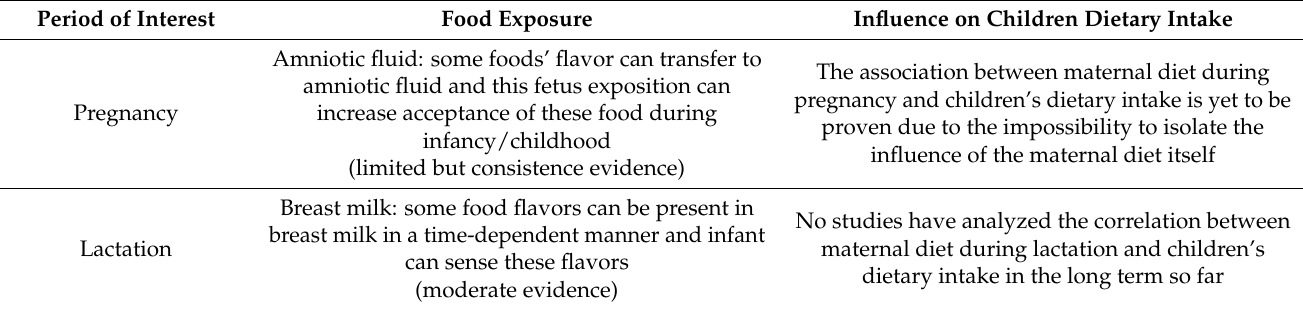
Table 1. Key factors in flavor perception and food preferences in